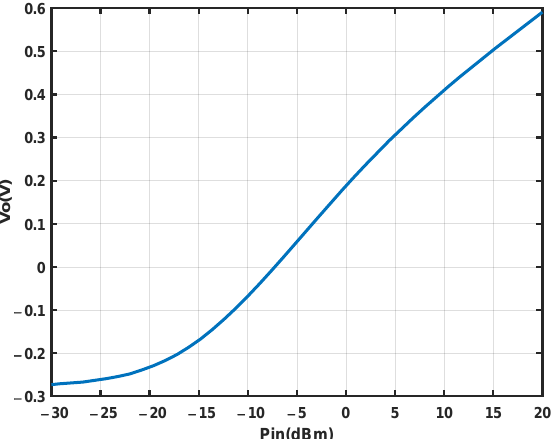
Figure 13. The input–output characteristics of the power detection